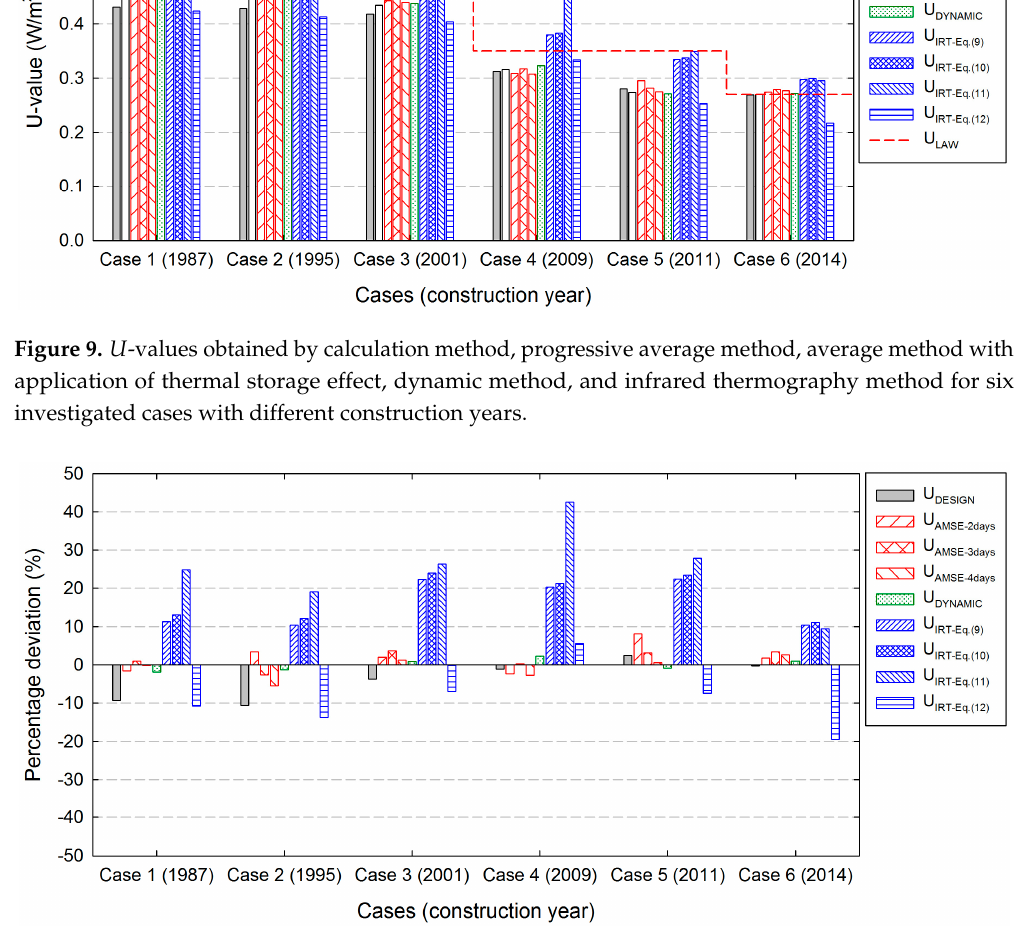
Figure 10. Percentage deviations among the U -values obtained by calculation method, average method considering the thermal storage effect, dynamic method, and infrared thermography method compared with one obtained by progressive average method.